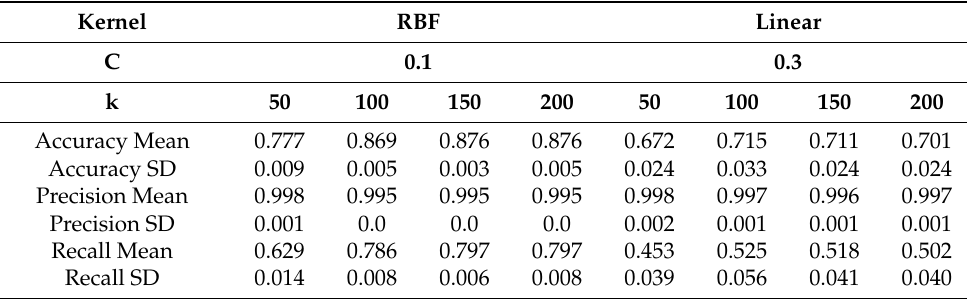
Table 2. Model Performance on Test Dataset without Data